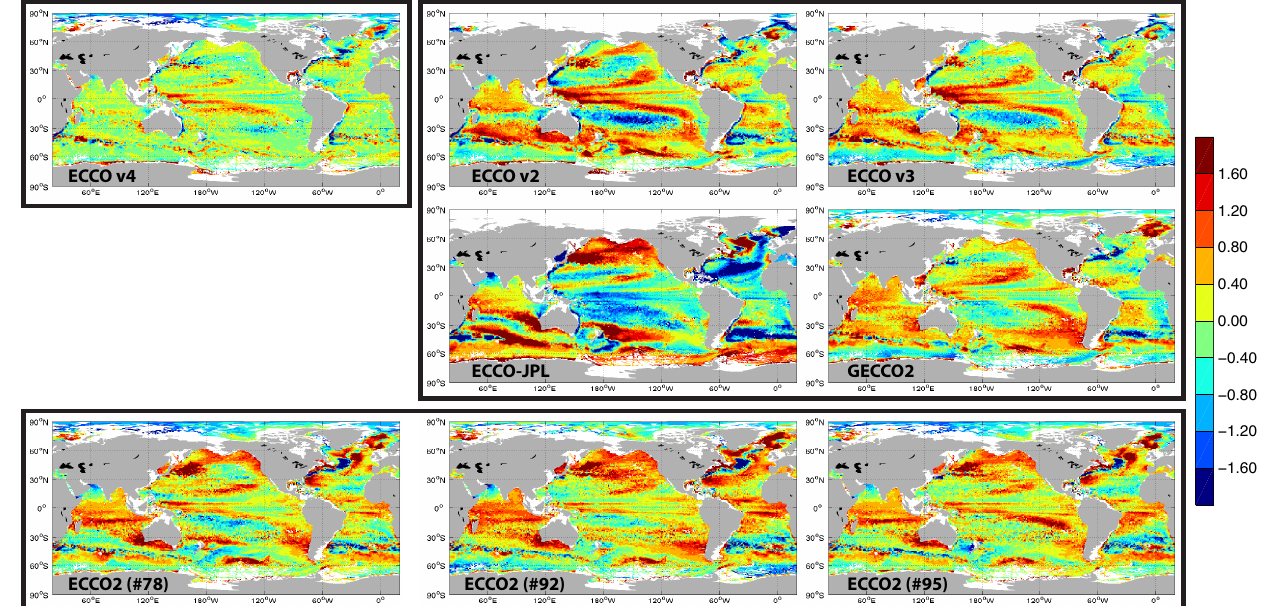
Figure 1. Model–data misfits for temperature at 300m depth (color scale in ◦ C). The ECCO v4 state estimate (Forget et al., 2015) used in this study is shown in the top left panel. The four panels in the top-right corner show earlier ECCO state estimates that use comparably coarse resolution grids (typically 1 ◦ as in ECCO v4). The ECCO v2, ECCO v3, and GECCO2 forcing fields were optimized using the adjoint method, whereas ECCO-JPL used a Kalman smoother instead. Unlike ECCO v4, these solutions use unoptimized turbulent transport parameters. The bottom three panels show ECCO2 eddying model solutions (with ≈ 1 / 6 ◦ resolution) that use different sets of forcing fields. Further details on the solutions and these misfits can be found in Forget et al.